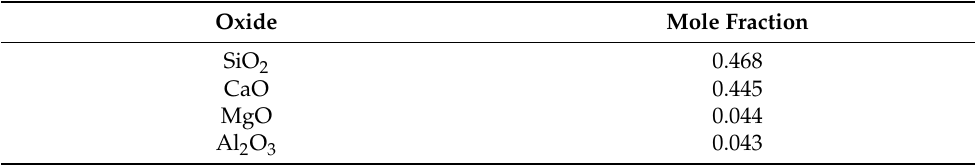
Table 1. Prepared CMAS composition measured by